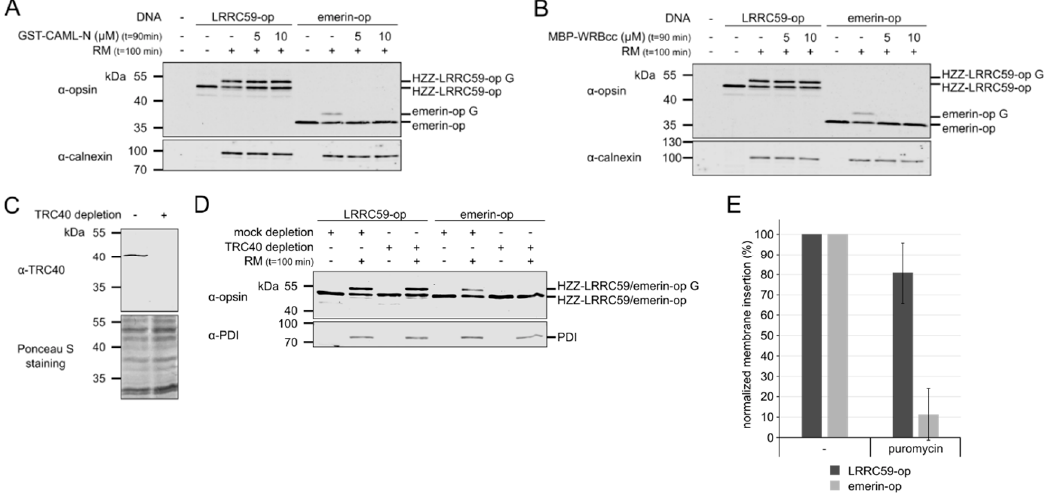
Figure 3. The TRC-pathway is not required for membrane insertion of LRRC59. ( A ) In vitro transcribed/translated HZZ-LRRC59-opsin or emerin-opsin was subjected to membrane integration assays using rough microsomes (RM) in the absence ( − ) or presence (+) of 5 or 10 µM GST-CAML-N, as indicated. Reactions were analyzed by SDS-PAGE followed by immunoblotting, using antibodies against the opsin-tag and against calnexin as loading control. Note that the emerin-construct used in this experiment lacks the N-terminal HZZ-tag. G indicates the glycosylated forms of LRRC59-opsin and emerin-opsin. ( B ) As ( A ), using MBP-WRBcc instead of GST-CAML-N. ( C ) The rabbit reticulocyte lysate used for coupled transcription-translation reactions was immunodepleted using antibodies against TRC40 (+) or IgG ( − ) as control. Depletion was analyzed by SDS-PAGE, followed by Western-blotting and Ponceau S- (bottom) and immunostaining using an antibody against TRC40. ( D ) Membrane insertion of HZZ-LRRC59-opsin and HZZ-emerin-opsin using TRC40- or mock-depleted lysates ( C ) for coupled in vitro transcription and translation with (+) or without ( − ) the addition of rough microsomes (RM), as indicated. Proteins were analyzed by SDS-PAGE, followed by immunoblotting using antibodies against PDI and the opsin-tag. ( E ) Quantification of membrane insertion reactions as in ( D ). Individual values were normalized to a reaction with mock-depleted lysate. Error bars indicate the standard deviation from the mean of five independent experiments.